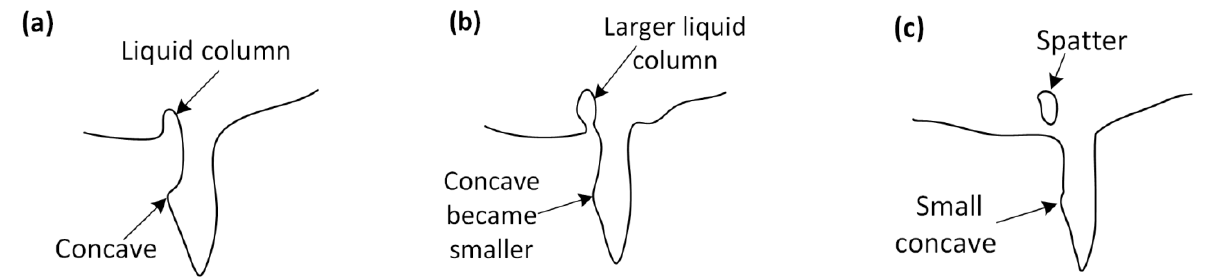
Figure 10. Flow velocity nephogram of molten pool when the welding time is 29 ms: ( a ) the preheating temperature is 300 K (ambient temperature), ( b ) the preheating temperature is 400 K, ( c ) the preheating temperature is 500 K.